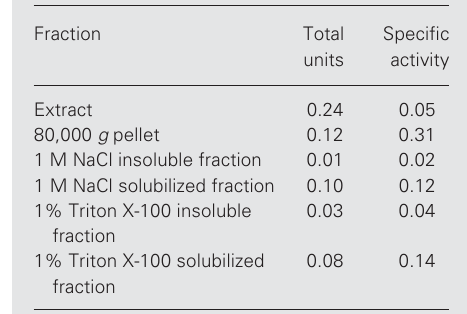
Table 2. Association of (cid:1) -L-fucosidase from Trypa- nosoma cruzi with membrane